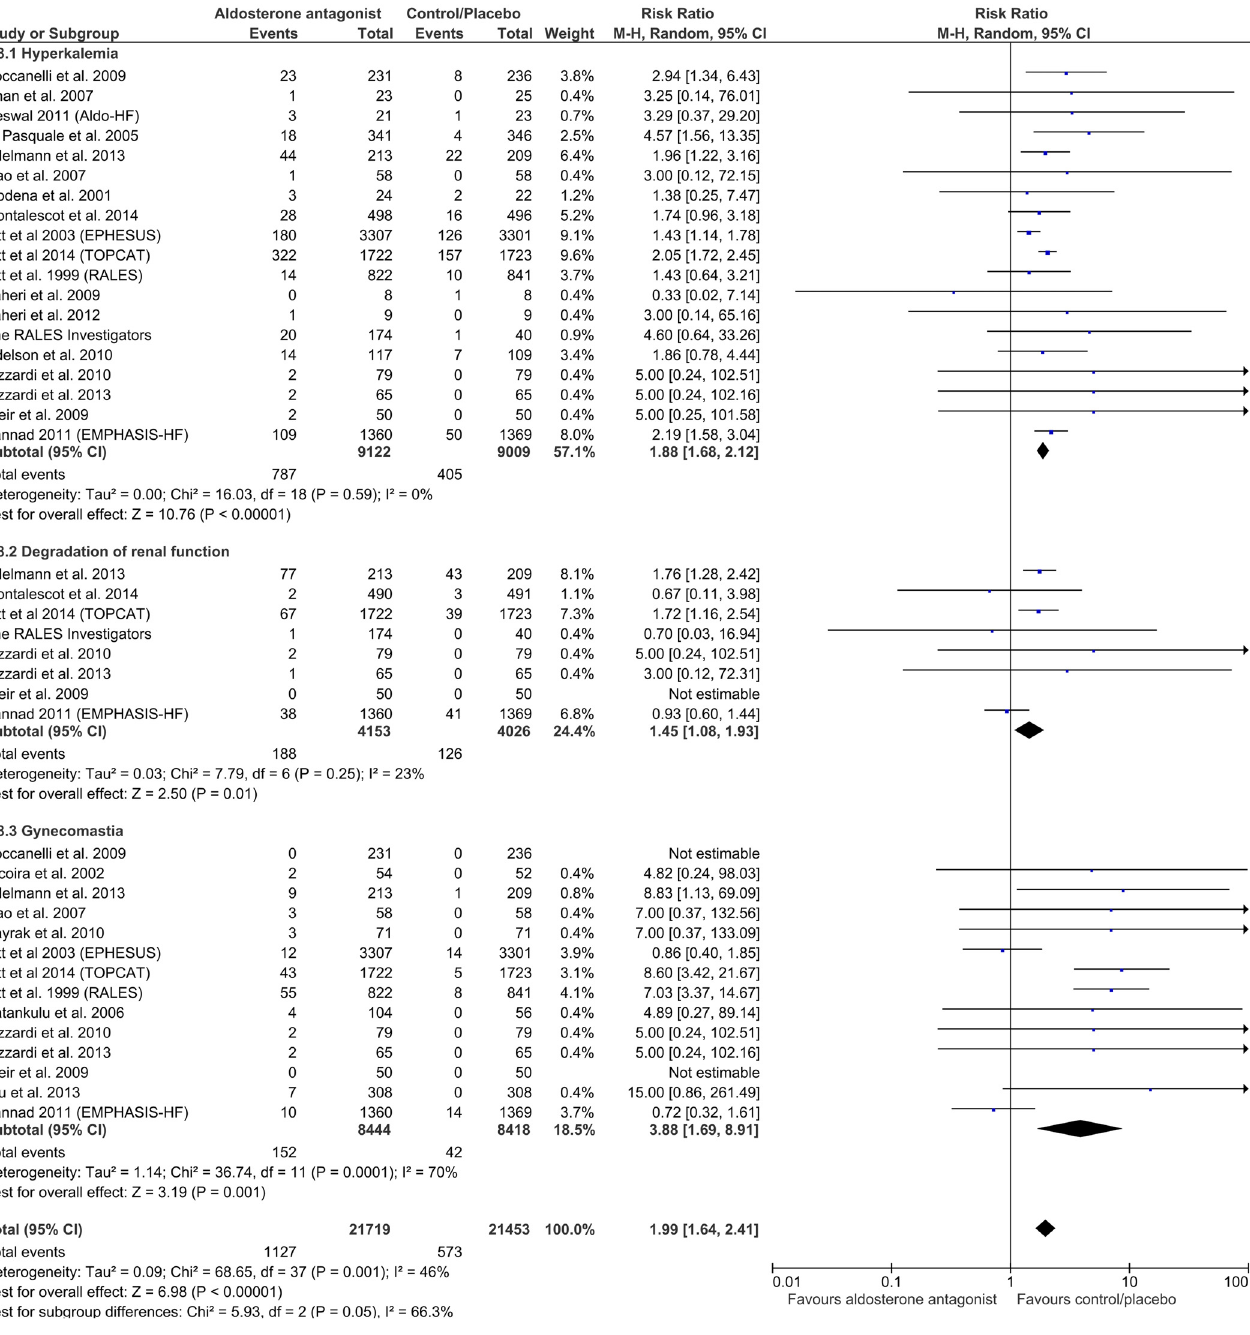
Fig 4. Incidences of adverse effects (hyperkalemia, degradation of renal function and gynecomastia) under aldosterone antagonist treatment, compared with control/placebo group, in patients with heart failure or myocardial infarction.